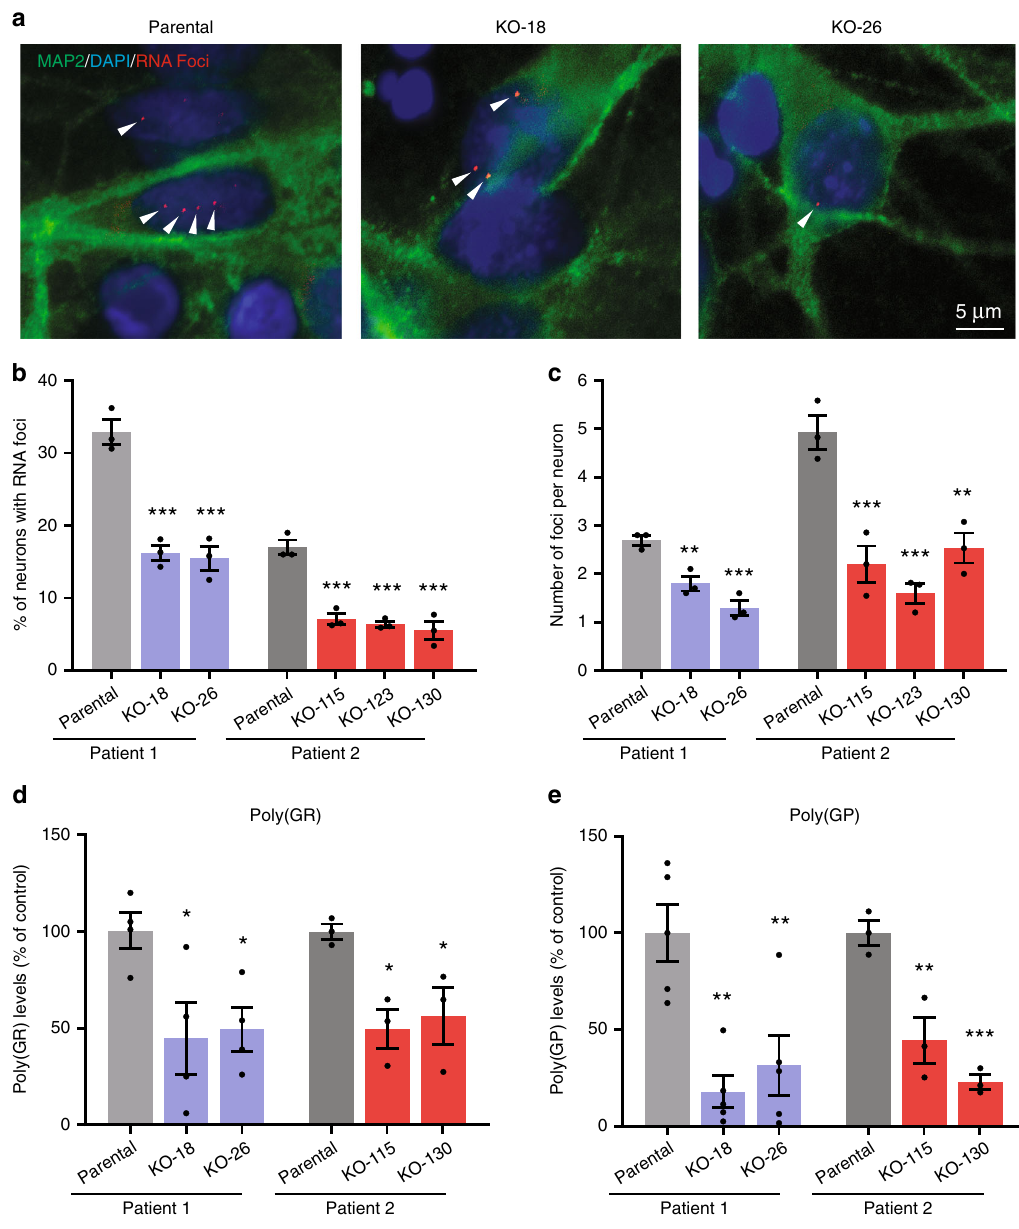
Fig. 8 AFF2 knockout (KO) reduces RNA foci and DPR proteins. a Representative images of fl uorescence in situ hybridization (FISH) analysis of parental and respective AFF2 -KO neurons with a Cy3-conjugated (G 2 C 4 ) 4 probe. RNA foci are red, neurons are green (MAP2), and the nuclei are blue (DAPI). b Percentage of C9ORF72 iPSC-derived neurons containing RNA foci labeled with a Cy3-conjugated (G 2 C 4 ) 4 probe. c Average number of RNA foci per neuron. Only neurons containing RNA foci were counted. Each data point is the average number of RNA foci in at least 100 neurons from an independent differentiation. Poly(GR) ( d ) and poly(GP) ( e ) levels in AFF2 -KO C9ORF72 neurons measured by MSD immunoassay. Each data point represents one differentiation ( n = 3 independent differentiations for all panels except n = 4 independent differentiations for patient 1 in d and n = 5 independent differentiations for patient 1 in e ). Values are mean ± s.e.m. * p < 0.05; ** p < 0.01; *** p < 0.001 (one-way ANOVA, Dunnett's multiple comparisons test). Source data are provided as a Source Data fi